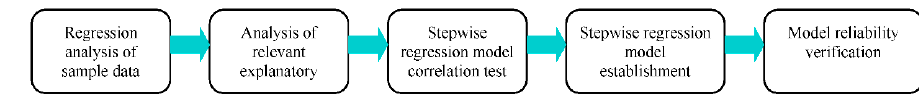
Figure 17. Predictive regression analysis technical workflow.